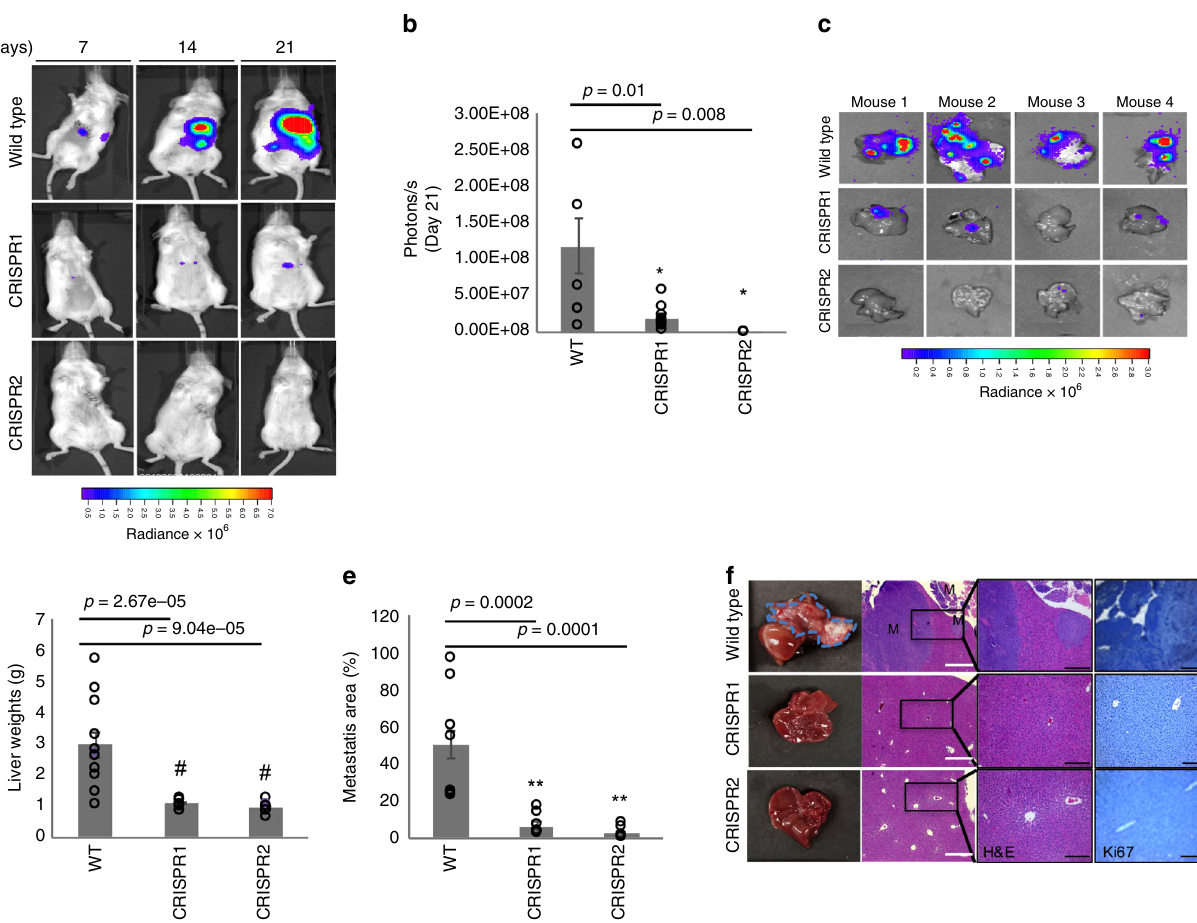
Fig. 5 RAMS11 induces liver metastasis via hemisplenectomy mouse model. a Representative mice showing no liver metastasis in RAMS11 CRISPR KO cell-injected mice by BLI. b RAMS11 CRISPR KO cell-injected mice show a signi fi cant decrease in liver metastasis by day 21. c Day 21 ex vivo mouse livers show decreased metastasis in RAMS11 CRISPR KO cell-injected mice by BLI. Wild-type cell-injected mice had d increased liver weights and e liver metastasis compared with CRISPR KO cell-injected mice. f Hematoxylin and eosin stain of livers showing metastasis (M) and levels of Ki67 stain. Three independent tissues were stained per group. White bar = 10 µ M, black bar = 100 µ M. Data shown as mean ± SEM and analyzed by two-tailed paired t -test, with WT n = 18, CRISPR1 n = 11, CRISPR2 n = 11 per group, experiment was repeated three times. * p < 0.05, ** p < 0.005, # p < 0.0005. Source data are provided as a Source Data